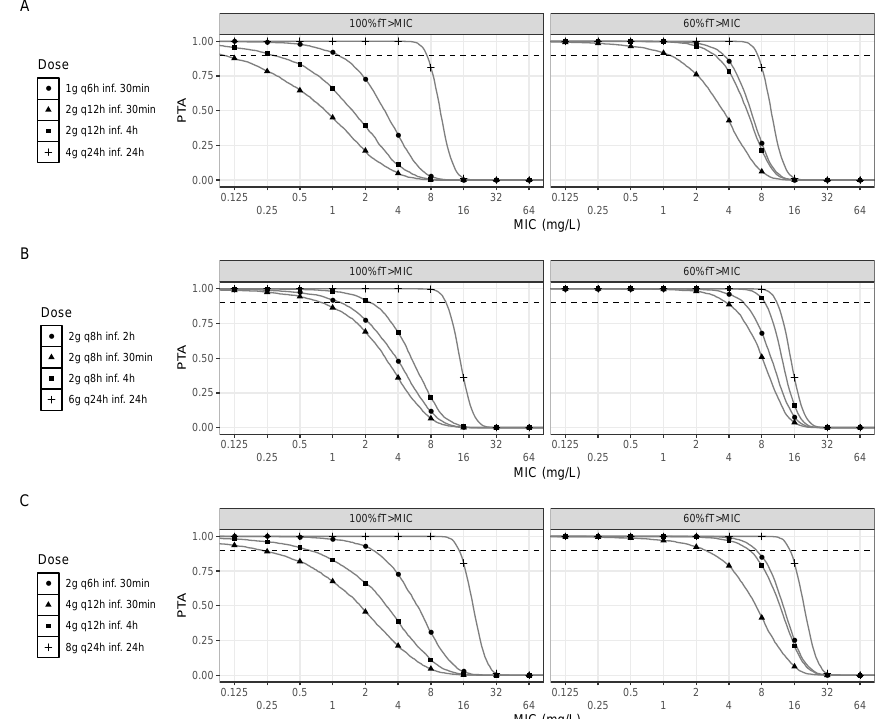
Figure 2. Probability of target attainment (PTA) for each of the 12 regimens (and the 2 PK/PD targets) using the final model and the population median value of S CR (0.54 mg/dL). The graphs indicate the total administration of 4 g ( A ), 6 g ( B ), or 8 g ( C ). Dashed lines, 90% of the simulated patients reached the specified target; f T > MIC , the percentage of the dosing interval that the free drug concentration is maintained above the